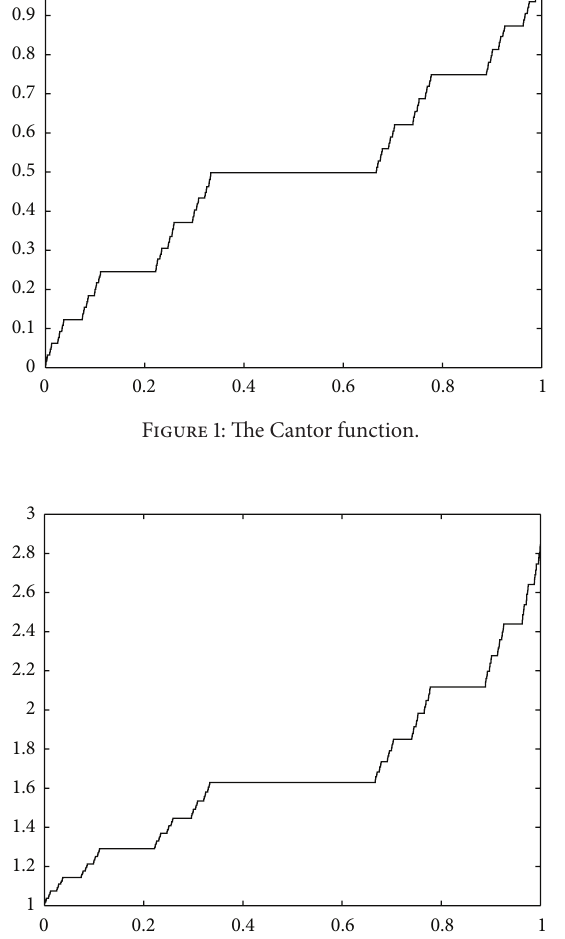
Figure 2: The Cantor-like function defined on the Cantor sets.